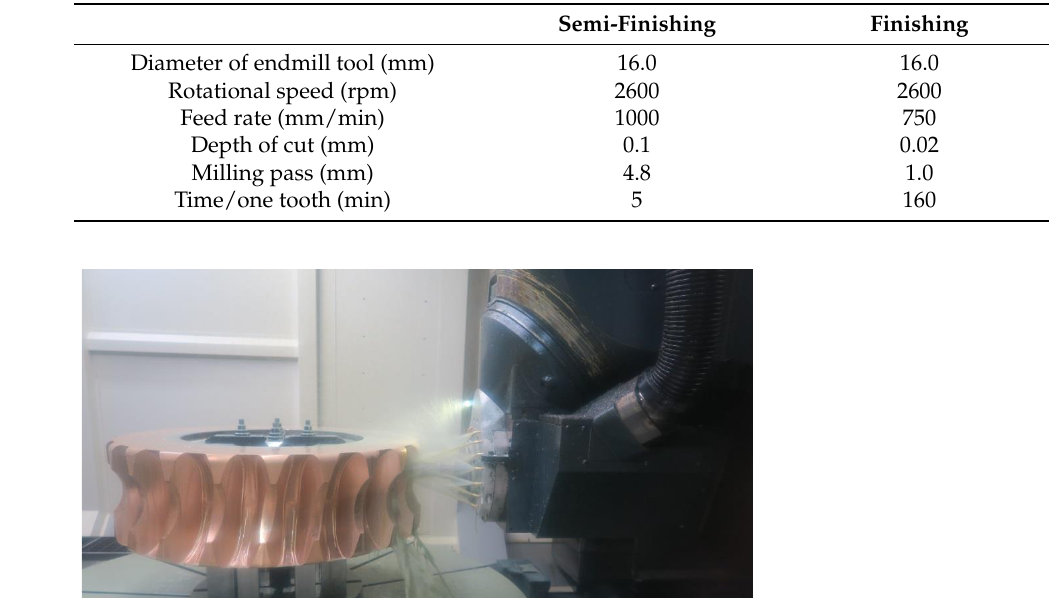
Table 3. Cutting conditions for semi-finishing and finishing operation in manufacturing of worm wheel.